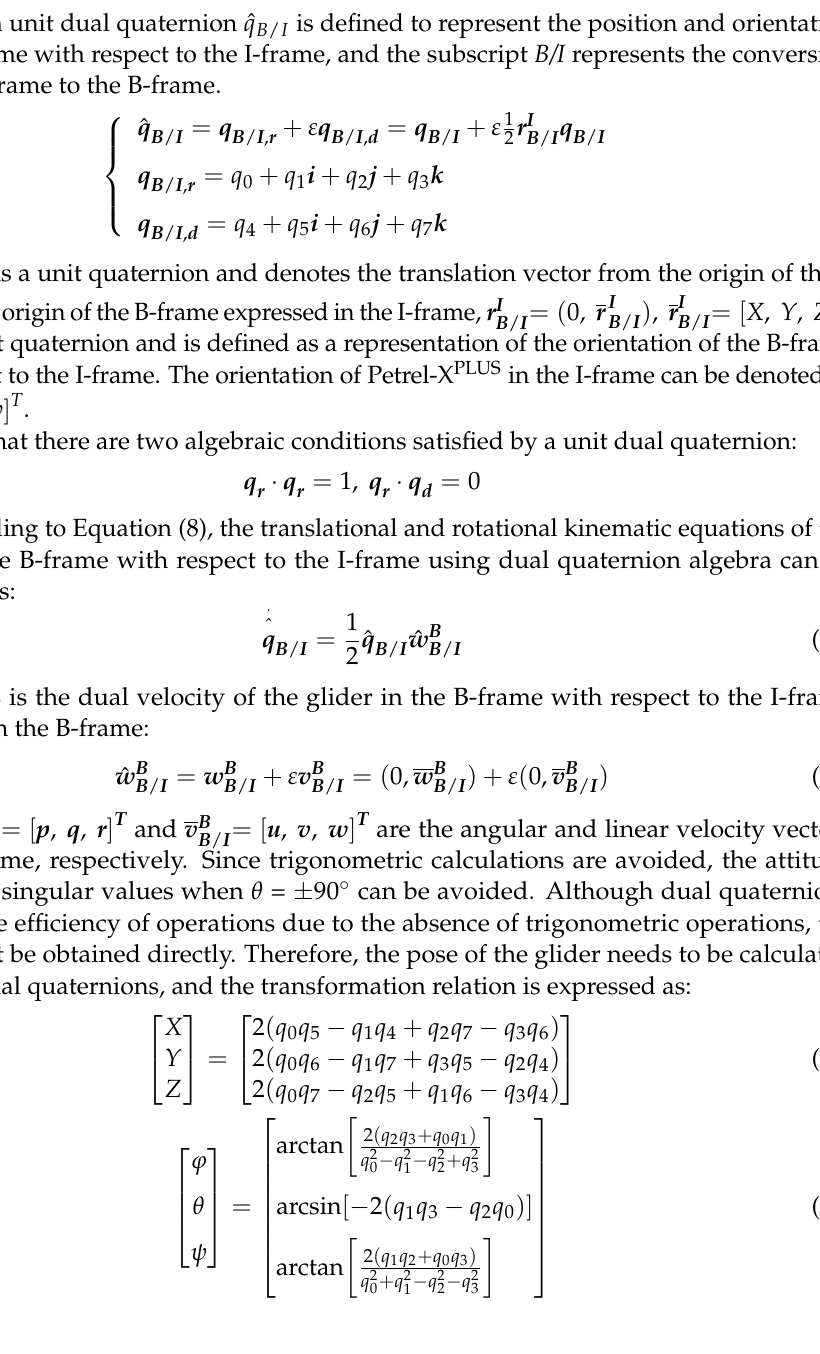
Figure 4. The coordinate system of Petrel-X PLUS .